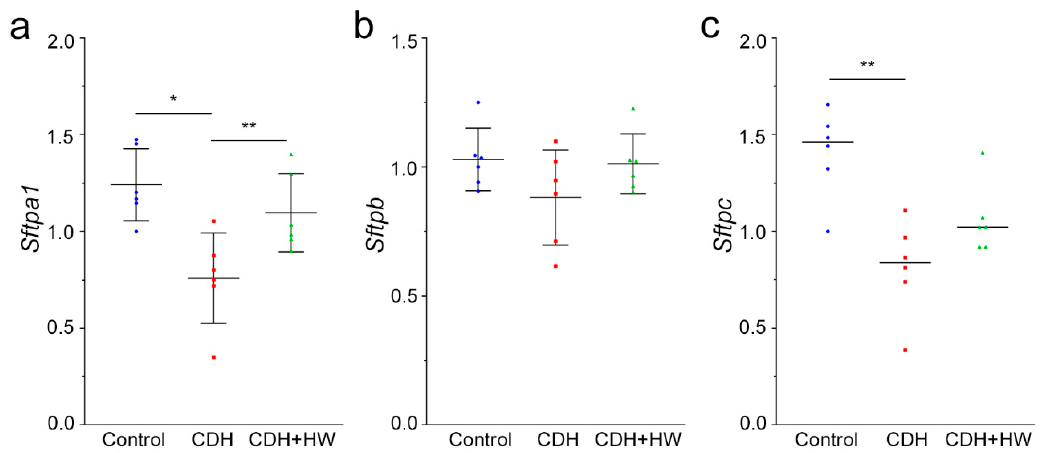
Figure 5. Surfactant protein A, B, C production. ( a ) Surfactant protein A1 mRNA ( Sftpa1 ) expression in the lungs derived from pups in the control, CDH, and CDH + hydrogen-rich water (HW) groups (each group, n = 6). The bars indicate the mean ± standard deviation (SD). * p < 0.01, ** p < 0.05; ( b ) Surfactant protein B mRNA ( Sftpb ) expression in the lungs derived from pups in the control, CDH, and CDH + HW groups (each group, n = 6). The bars indicate the mean ± SD; ( c ) Surfactant protein C mRNA ( Sftpc ) expression in the lungs derived from pups in the control, CDH, and CDH + HW groups (each group, n = 6). The bars represent the median. ** p <